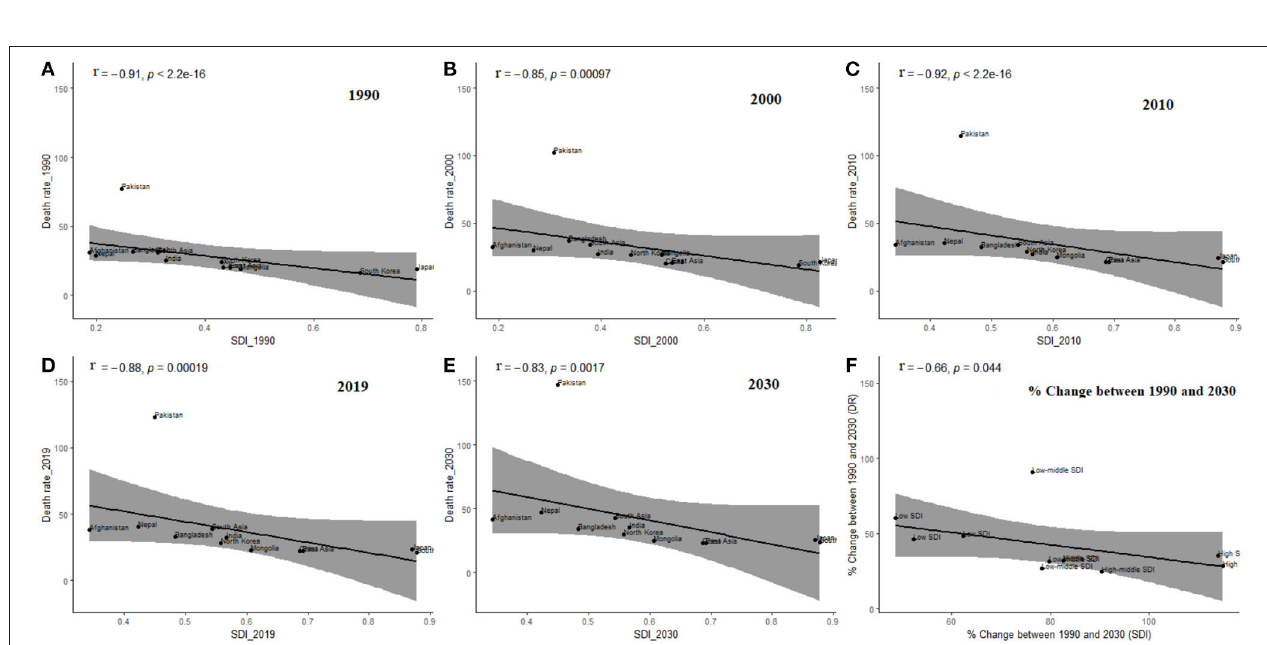
FIGURE 6 | Relationship between death rate (DR) and sociodemographic index (SDI) within Asian region including East and South Asia, in different prediction period, (A) 1990, (B) 2000, (C) 2010, (D) 2019, (E) 2030, (F) % Change between 1990 and 2030; The black dots represent the breast cancer related DR of each country, the black lines are the fitting lines of correlation trend, and grey shaded area is the 95% confidence interval for fitting results. DR, mean death rate (per 100k) from age 20 to 84 years.